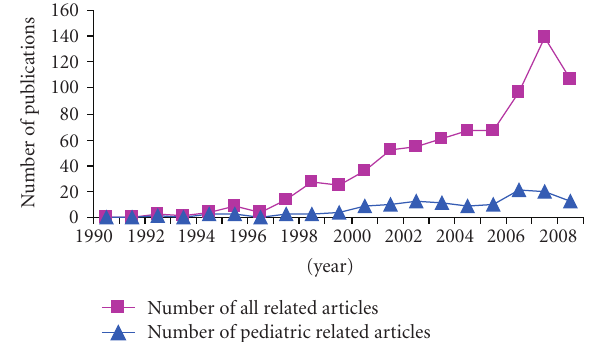
Figure 1: Trends of publications in Pubmed related to abdominal compartment syndrome (1990–2008).